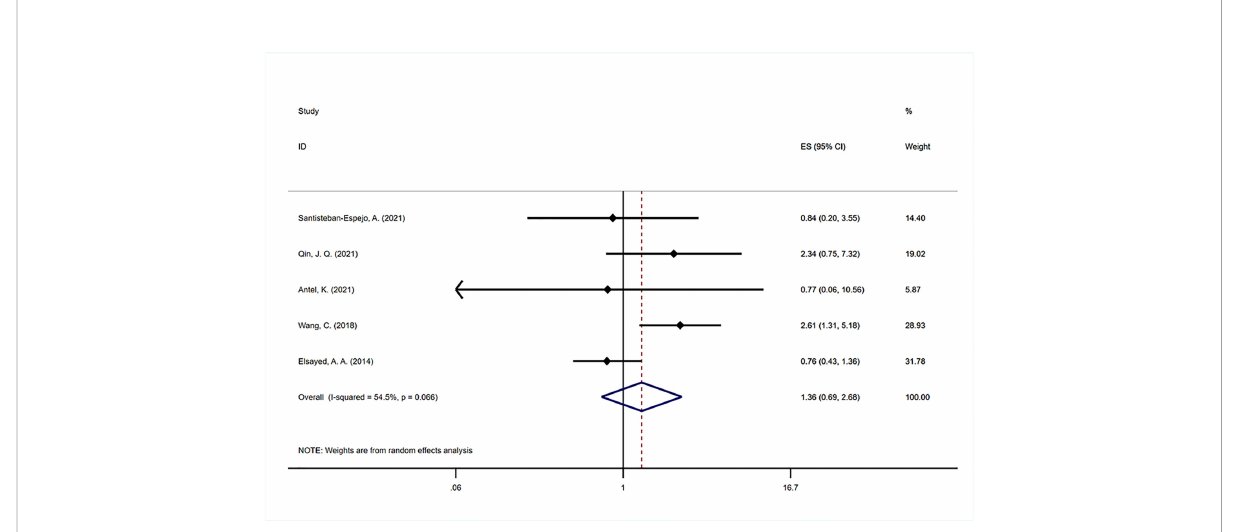
FIGURE 4 Forest plot of the hazard rations for progression free survival (PFS) between patients with EBV-positive and EBV-negative